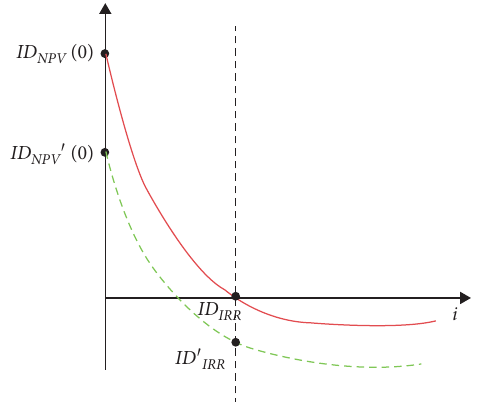
Figure 2: NPV curve of transnational investment project with a single investment.